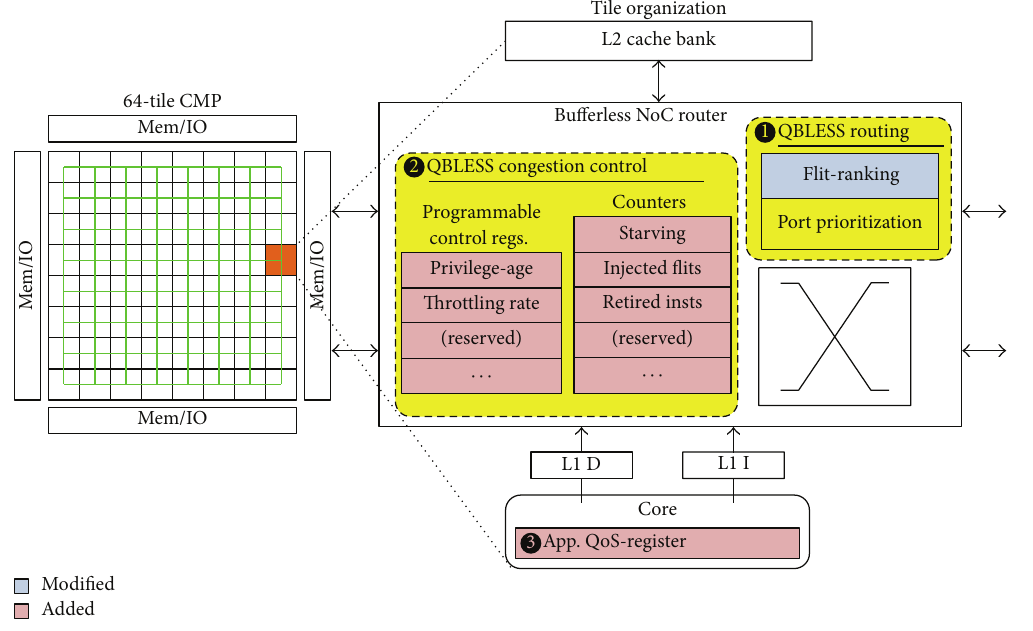
Figure 3: QBLESS router